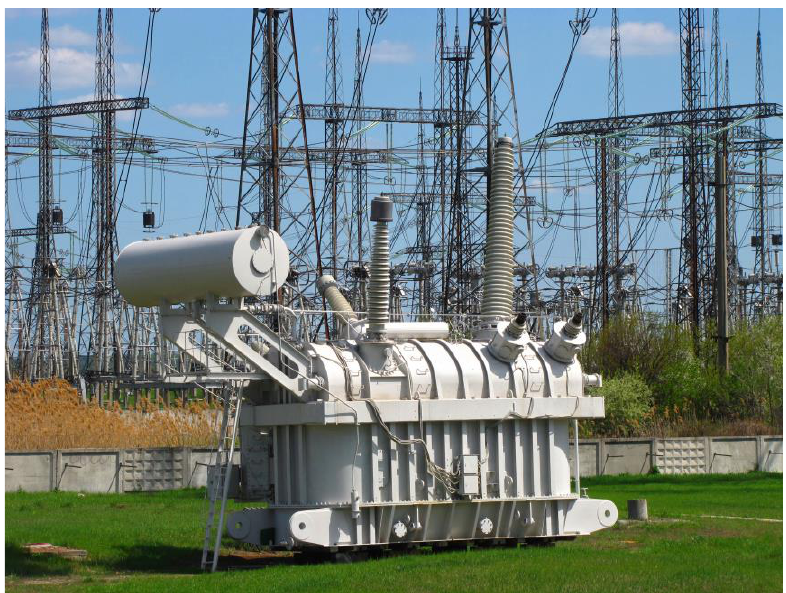
Figure 3. A photo of a high-voltage (750 kV) power transformer. Source: Wikimedia Commons repository, author: Novoklimov, https://commons.wikimedia.org/wiki/ File: